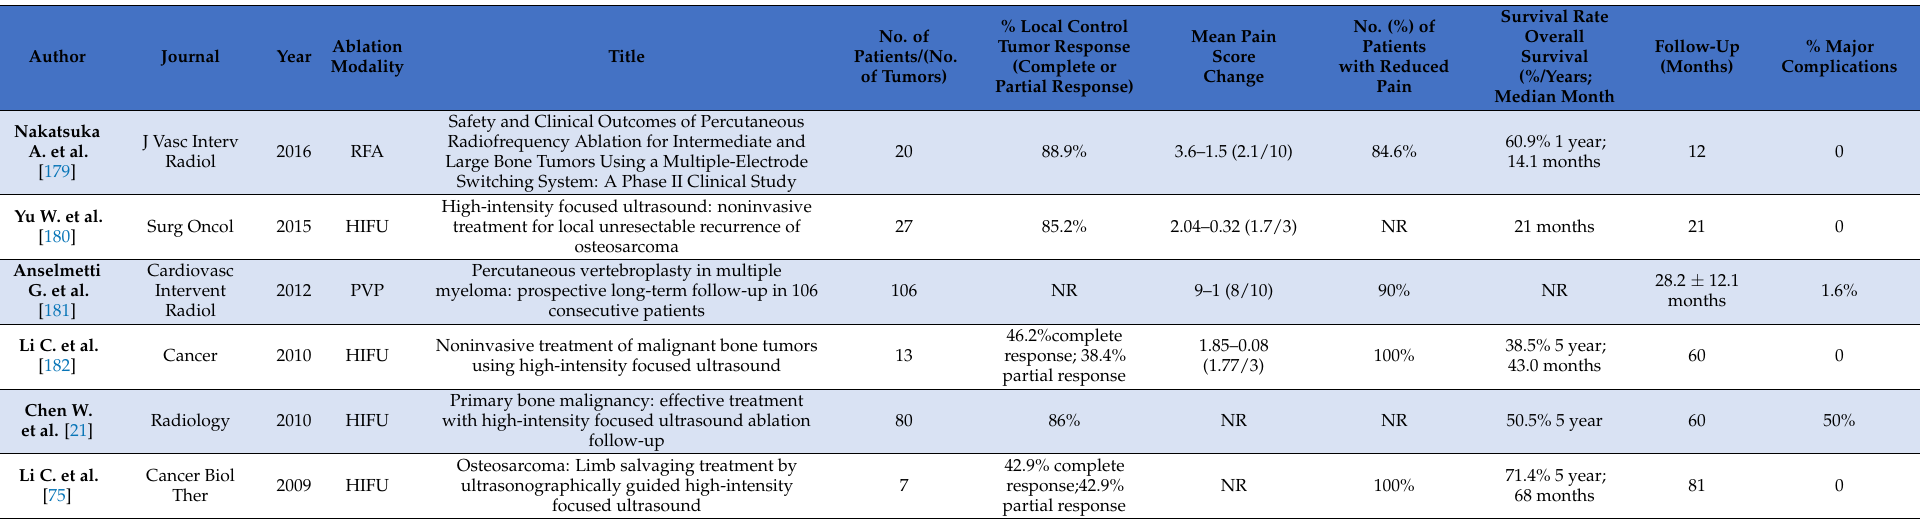
Table 5. Results of primary bone